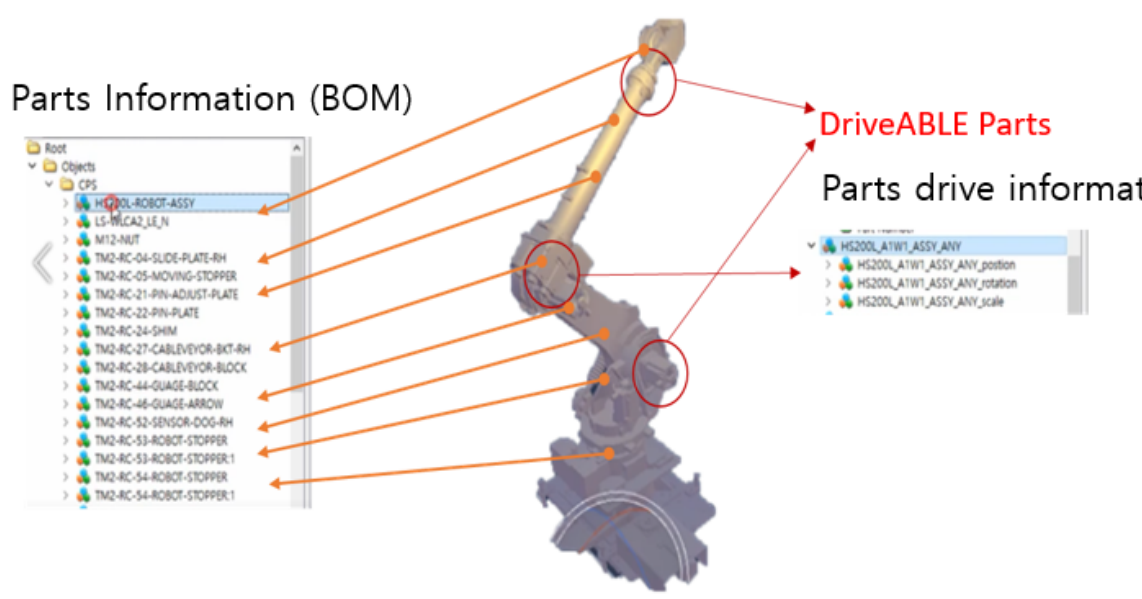
Figure 13. Address Space implementation of 3D